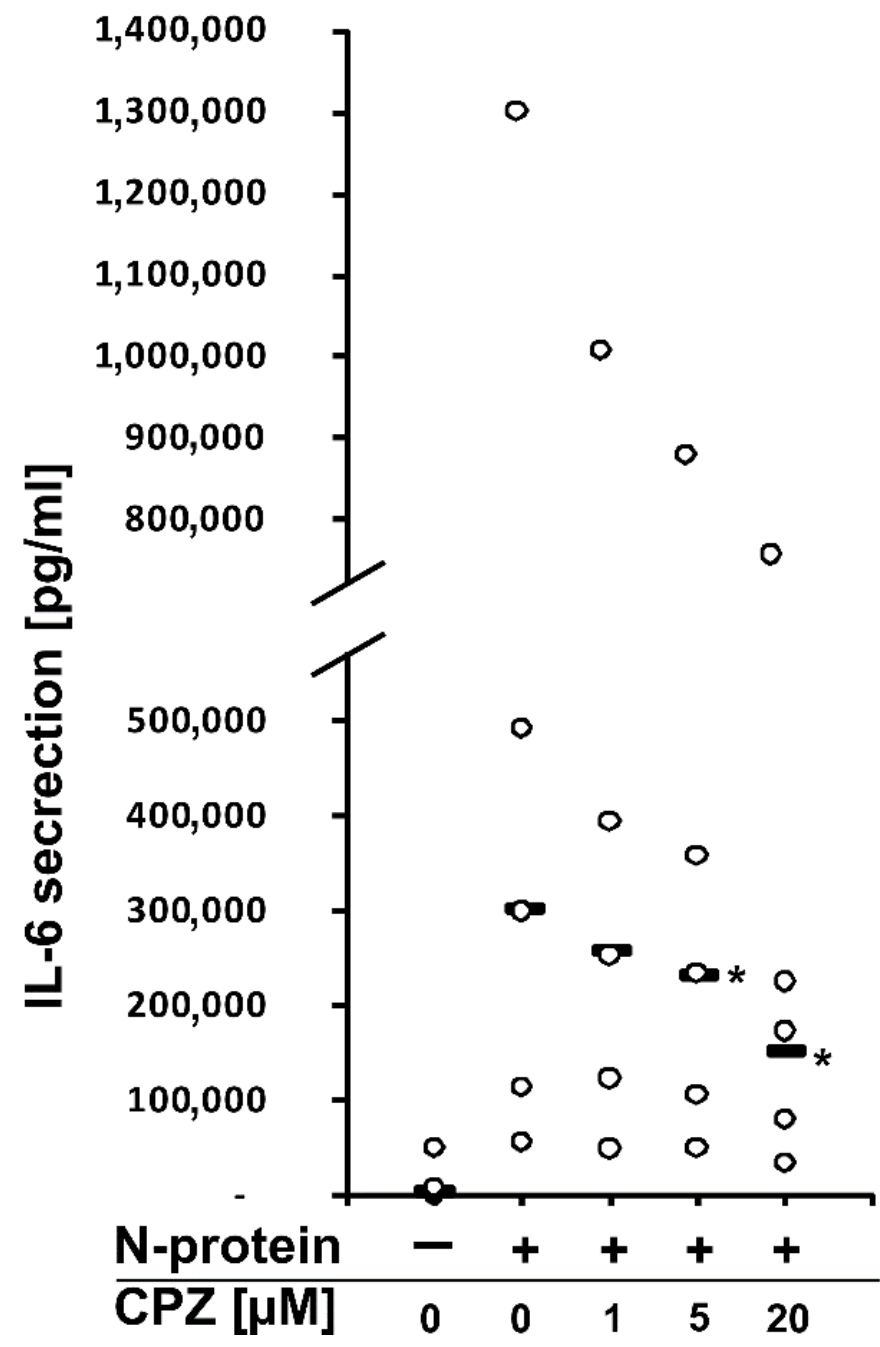
Figure 4. Chlorpromazine inhibits the SARS-CoV-2 nucleocapsid-mediated release of IL-6 in human monocytes isolated from healthy donors. Human monocytes were pretreated with the indicated chlorpromazine concentrations for 3 h; after pretreatment, the cells were stimulated with SARS-CoV-2 nucleocapsid protein at a concentration of 1 µ g/mL for 48 h. Then, the cells were collected for RNA extraction, and the supernatants were collected for ELISA. IL-6 concentrations were determined using the human IL-6 Quantikine ELISA Kit. Data are shown as dot plots with median values from five independent donors (n = 5). Asterisks indicate a statistically significant difference at p < 0.05. Statistical analysis was performed using Friedman Repeated Measures ANOVA on Ranks followed by Student-Newman–Keuls post hoc